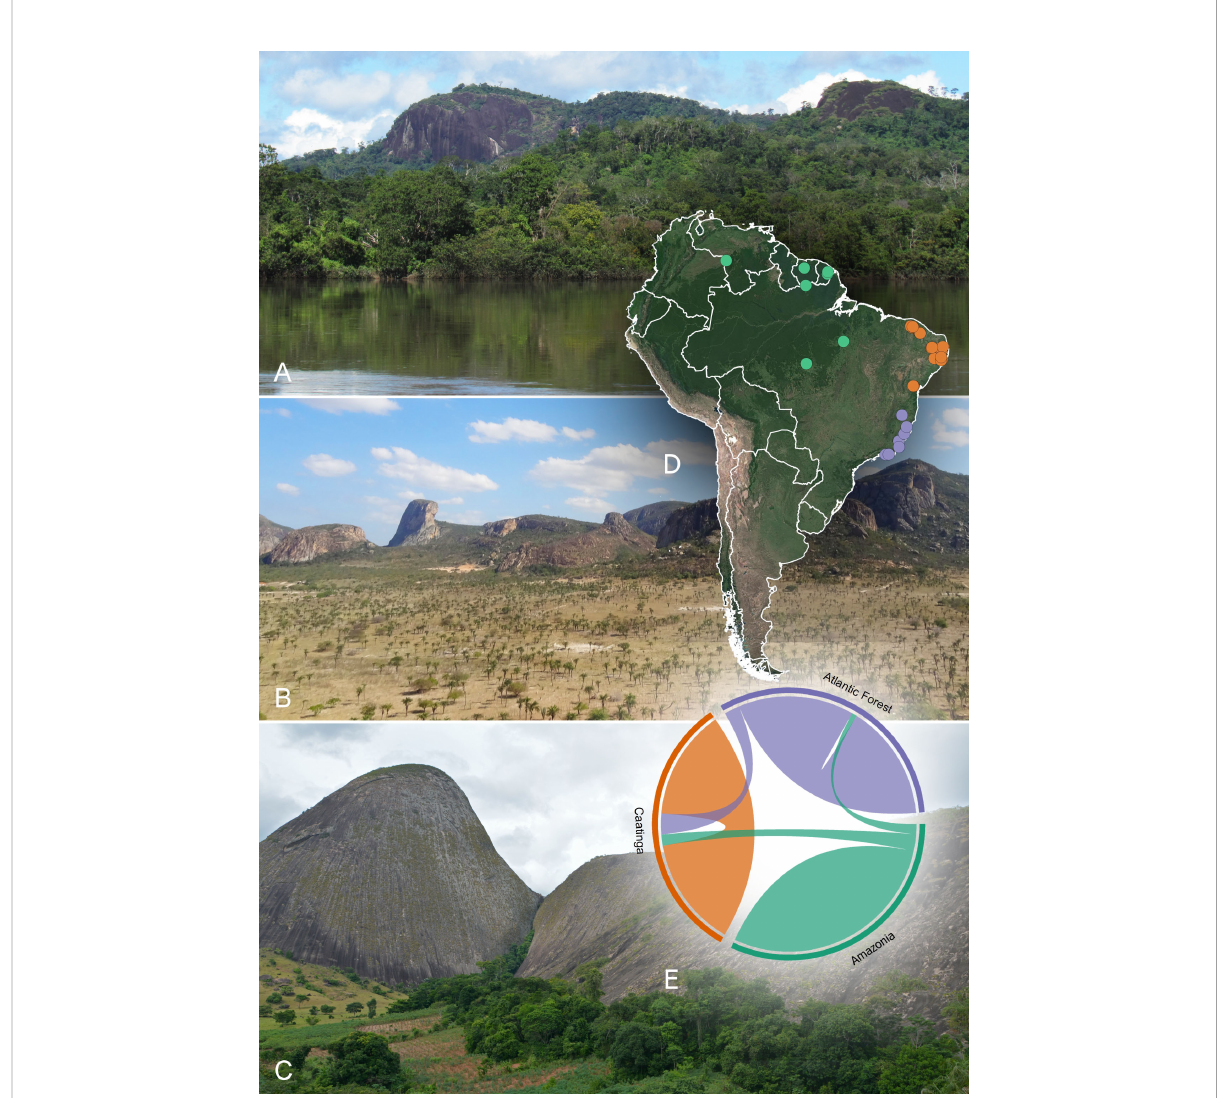
FIGURE 1 Inselbergs located in the three Neotropical biomes analysed: Amazonian (A) Serra Grande, Canta ́ municipality; Caatinga (B) Itatim municipality; and Atlantic Forest (C) Pedra do Caladão, Carlos Chagas municipality, Minas Gerais state. (D) Distribution map of the 50 inselbergs in South American sites used in the analyses with their classi fi cation by Neotropical biome. The green markers indicate the inselbergs located in the Amazonian biome, orange markers indicate those located in the Caatinga biome, and mauve markers indicate those in the Atlantic Forest biome. (E) Overlap in species composition between inselbergs in the Amazonian, Caatinga and Atlantic Forest biomes. Photos a-b RGBS; c